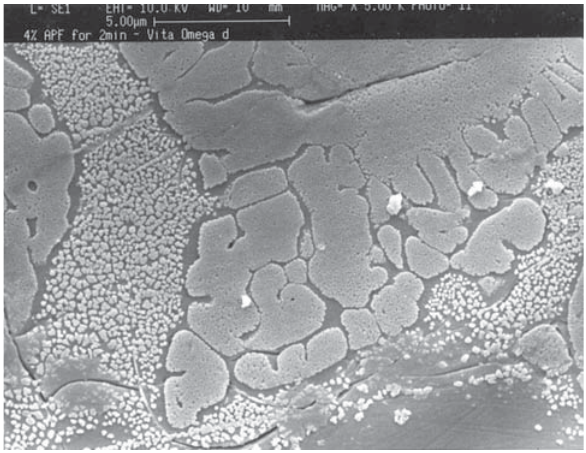
FIGURE 3- Photomicrographs of APF-etched Vita Omega dentine ceramic (Vita Zahnfabrik, Bad Sackingen, Germany), a leucite based feldspathic ceramic. This acid seems to build up surface deposits preferentially on the leucite crystal phase. From Della Bona and Anusavice 25 ,